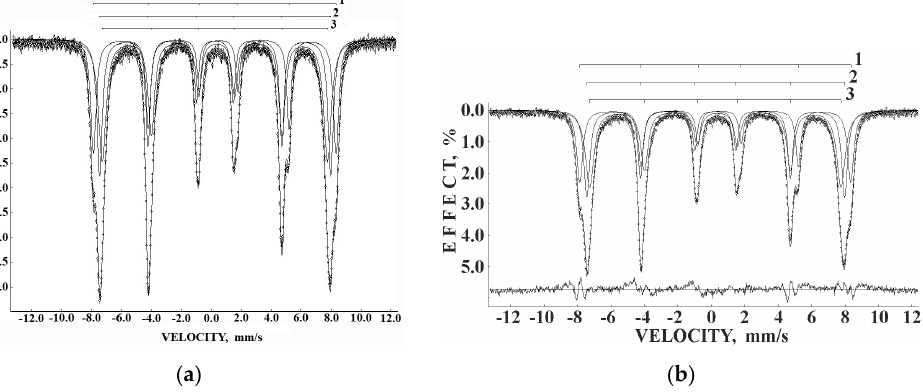
Figure 61. Mössbauer spectrum of CuFe 2 O 4 measured with a high velocity resolution and converted into the 1024‑channel spectrum and fitted using three magnetic sextets without the differential spec‑ trum, adapted from Ref. [91] with permission from Springer Nature: Hyperfine Interactions, “Study of CuFe 2 O 4 –SnO 2 nanocomposites by Mössbauer spectroscopy with high velocity resolution”, Os‑ htrakh M.I., Kalai Selvan R., Augustin C.O., Semionkin V.A., ©2008. ( a ) and the same fit with the differential spectrum on the bottom showing large misfits ( b